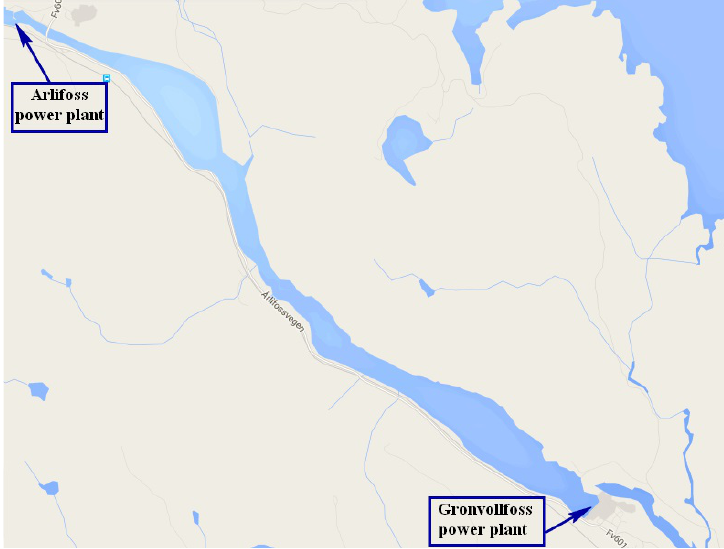
Figure 3: Google map showing a part of the river Tinnelva between ˚ Arlifoss and Grønvollfoss power plants. 3